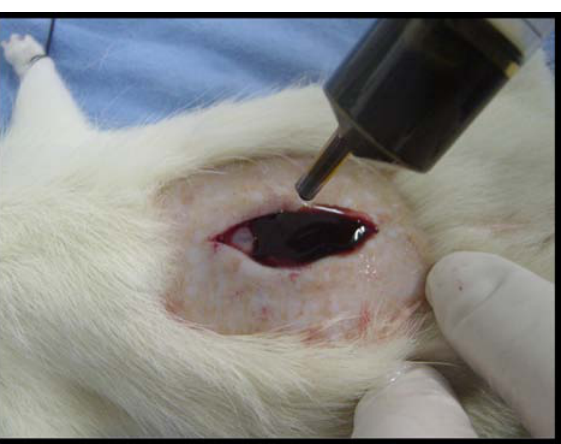
FIGURE 3 - Picture showing wound being cleaned saline solution.